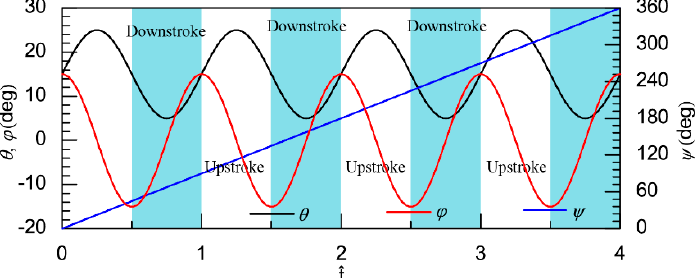
Figure 8. Variation of flapping angles, twisting angles, and rotary angles in four periods.